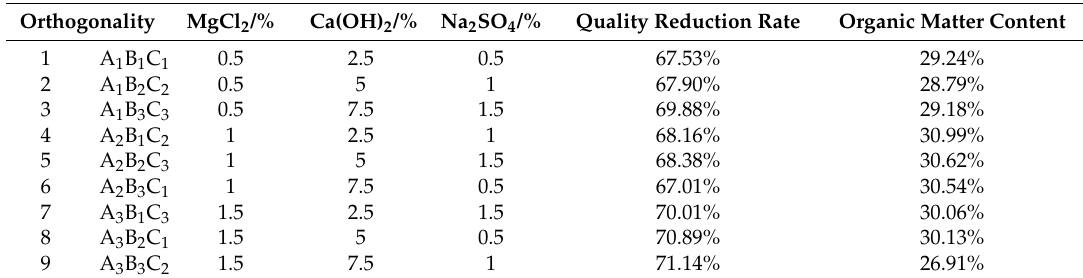
Table 1. Results of the orthogonal experiments.